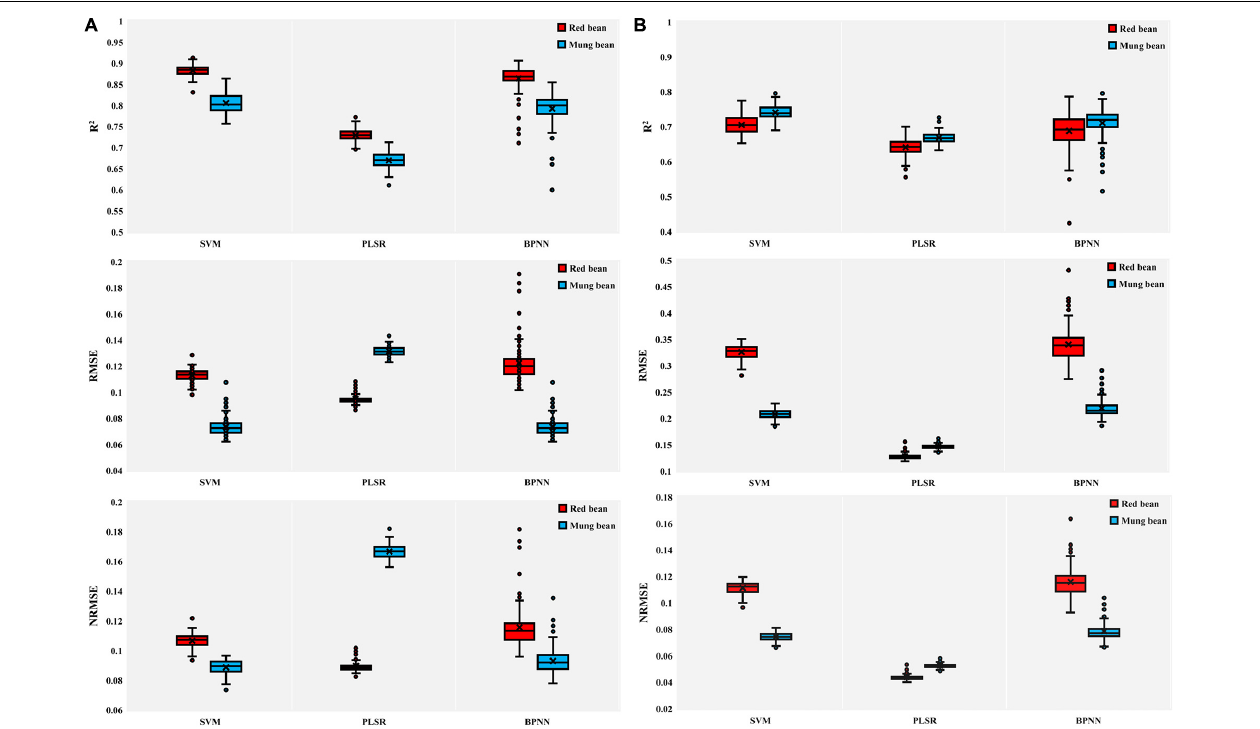
FIGURE 6 | Boxplots for the coefficient of determination ( R 2 ), root-mean-square error (RMSE), and normalized RMSE (NRMSE) of the training results of SVM, PLSR, and BPNN models. (A) AGB of red bean and mung bean; (B) LAI of red bean and mung bean. The point plots indicate outliers encountered during the phase of the 100 different verifications repetitions and the black multiplication sign indicates the mean